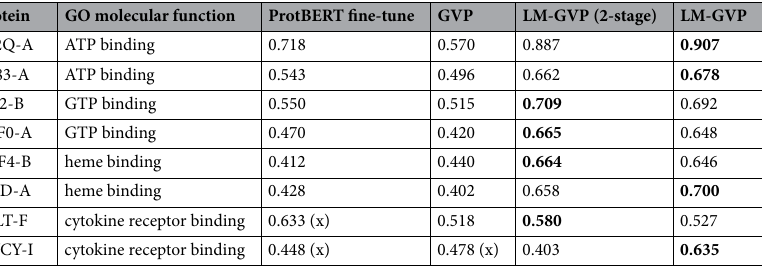
Table 3. Area under the receiver operating characteristic curve (AUROC) quantifying the agreement between saliency scores and known active sites responsible for respective molecular functions (MF). (x) indicates a false prediction. The top performing model is shown in